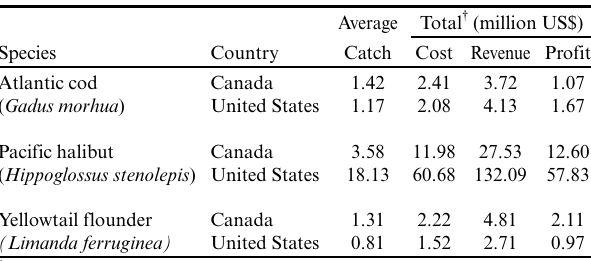
Table 1 . Current average (2005 to 2014) catch (million tonnes), total cost, revenue, and discounted (at 5%) profit (million US$ 2010) by species and country.